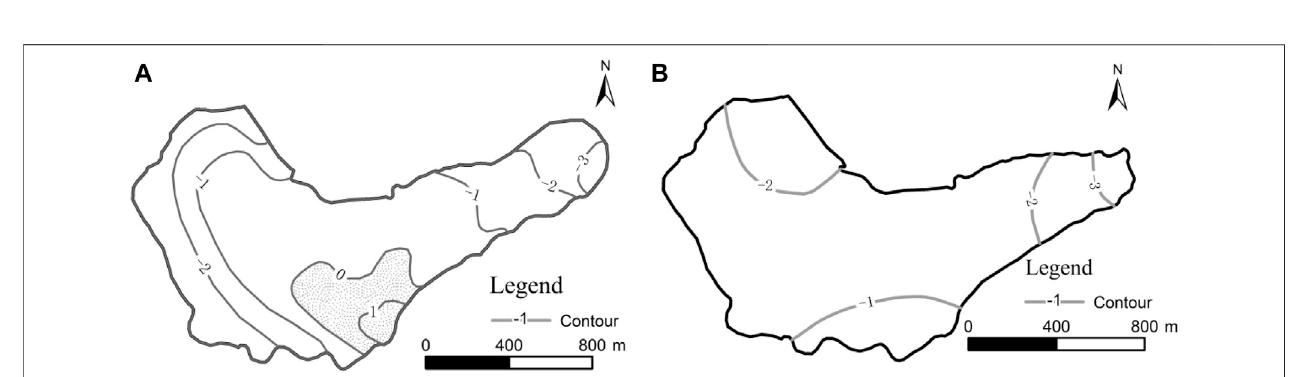
FIGURE 5 | Spatial distribution of the contour line for the mass balance of the Baishui River Glacier No. 1 during (A) 2000 – 2010 and (B) July 27 to 15 September 2019.